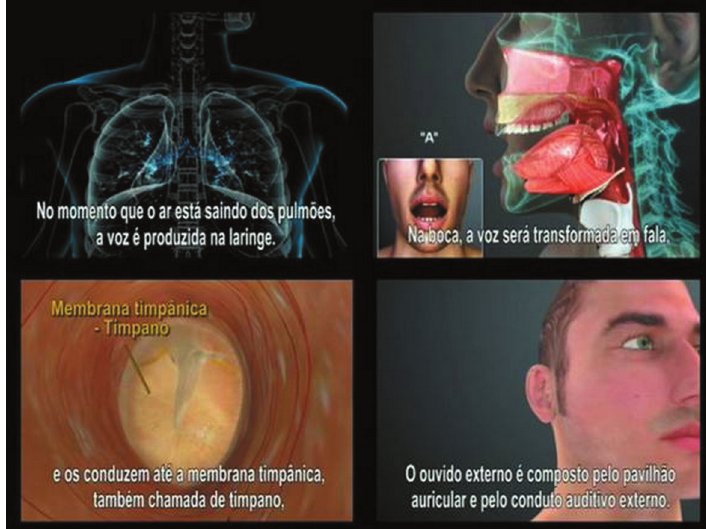
Figure 1- Study Object, CD-ROM Virtual Man Voice Assessment and Virtual Man Hearing